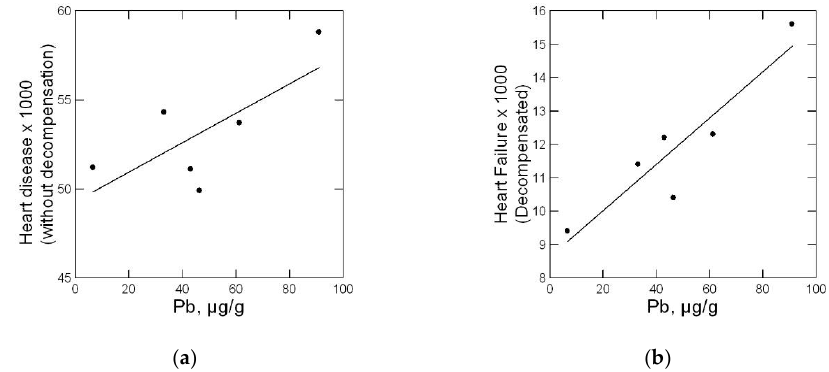
Figure 1. Correlation between the median value of the Pb concentration (as µg/g) measured in samples of tree bark and the incidence of heart diseases in six Socio Health Districts: ( a ) heart disease without decompensation × 1000 inhabitants ( r = 0.723; p = 0.100); ( b ) decompensated heart failure × 1000 inhabitants ( r = 0.919; p = 0.010).